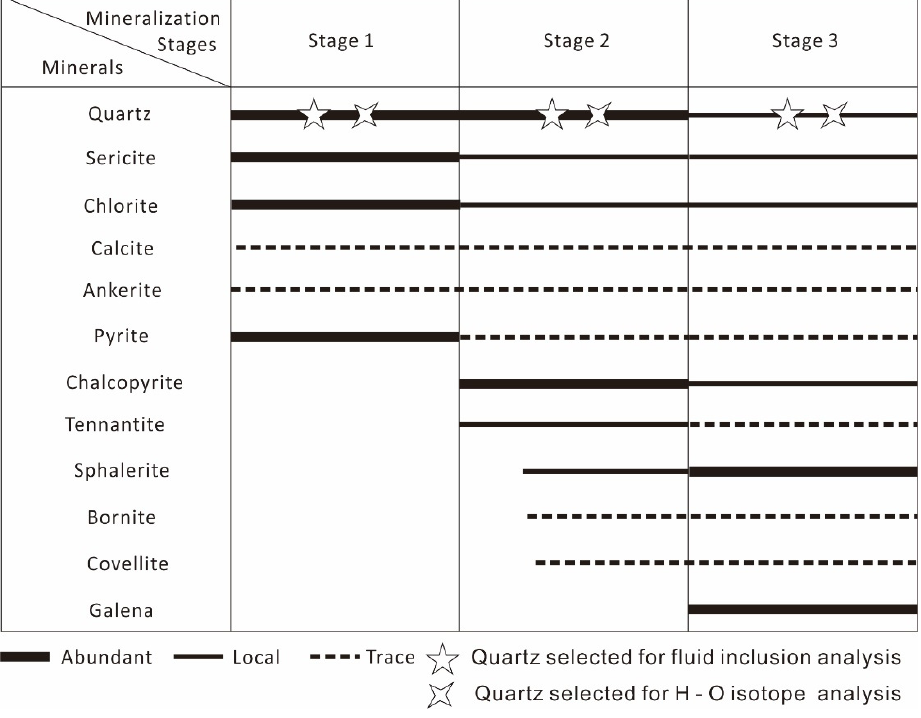
Figure 4. The mineralization stages and paragenetic sequences of the Xialiugou deposit.